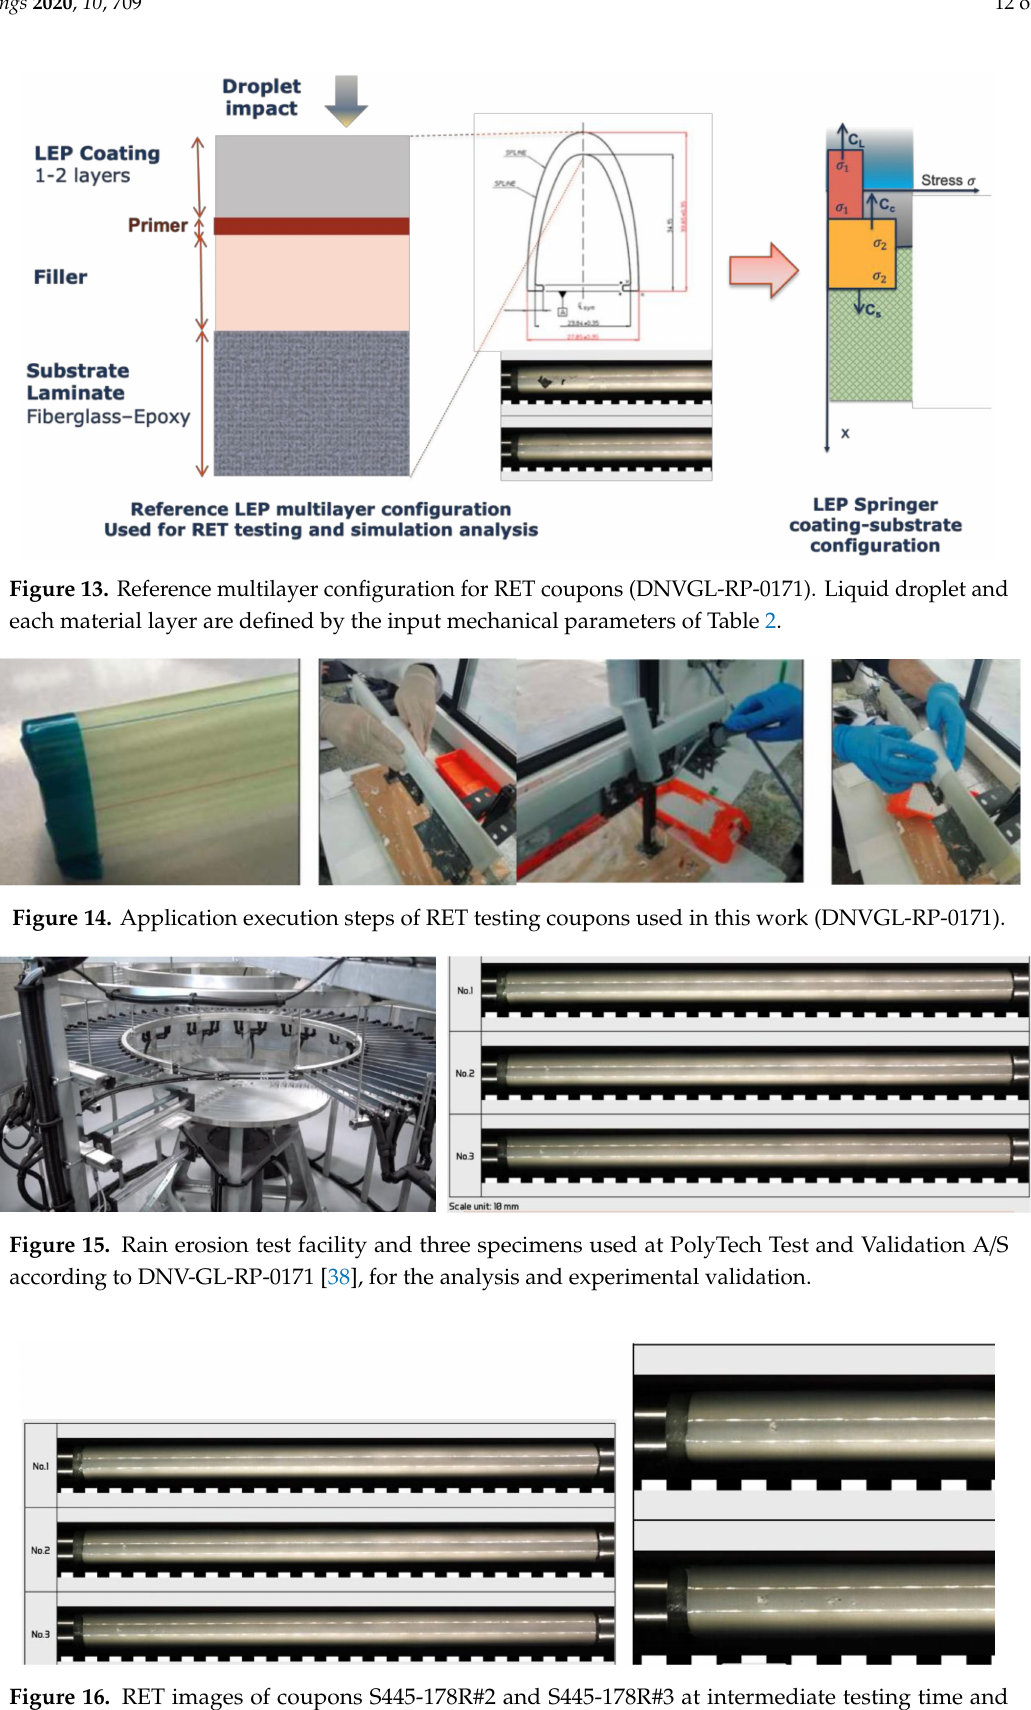
Figure 16. RET images of coupons S445-178R#2 and S445-178R#3 at intermediate testing time and zoom details to appreciate erosion